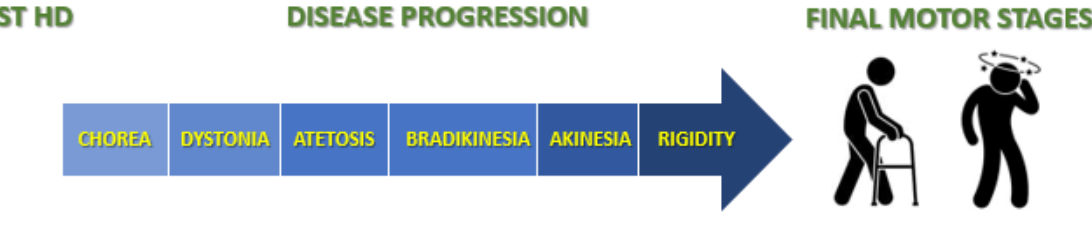
Figure 1. Motor symptoms related to disease progression.